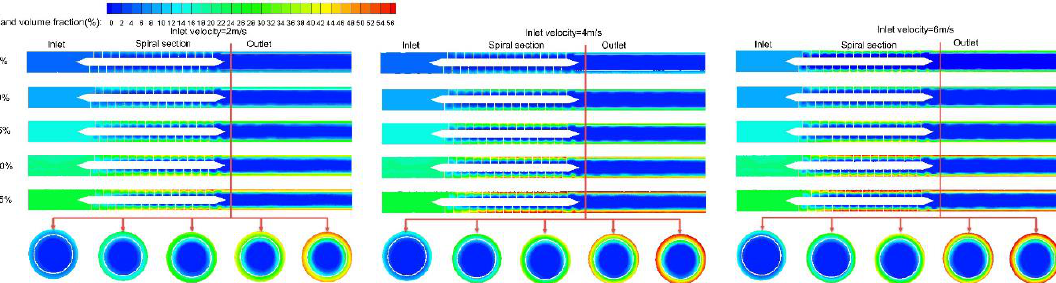
Figure 11. NGH distribution contours across the horizontal section of the spiral separator and the vertical section at the outlet with di ff erent inlet sand volume fraction. Energies 2020 , 13 , x FOR PEER REVIEW 10 of 15